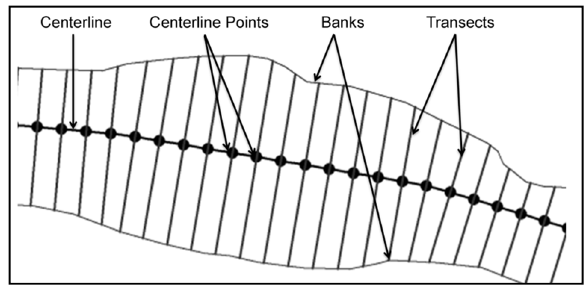
Figure 2. Delineation of a river polygon, centerline, points placed on the line every 50 m, and transects through each point that cross the polygon to both banks.